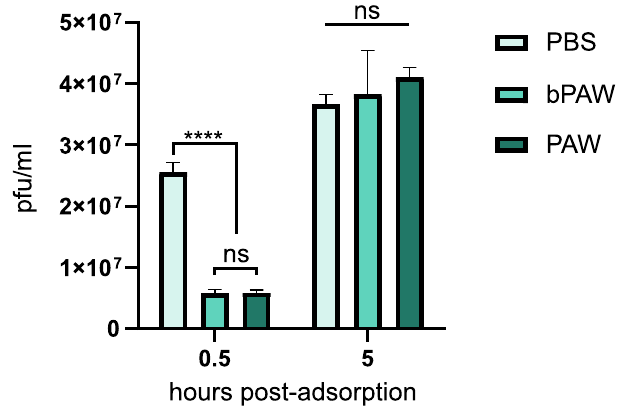
Figure 3. Effect of PAW ultrasonic nebulization on SARS-CoV-2 infectivity. The figure depicts the results for a representative experiment. Serial dilutions of SARS-CoV-2 inoculum were adsorbed to Vero E6 cell monolayers for either 0.5 or 5 h before nebulization with different media. Nebulization was maintained for 10 min before washing with DMEM. Viral titers were then estimated by plaque assay. PBS nebulization was used as a negative effect control. Mean ± SD viral titers are shown. Two-way anova with Tukey’s post-hoc test. ****p<0.0001.; ns: non-significant. Generated with INKSCAPE 1.1 (www. inksc ape. org).